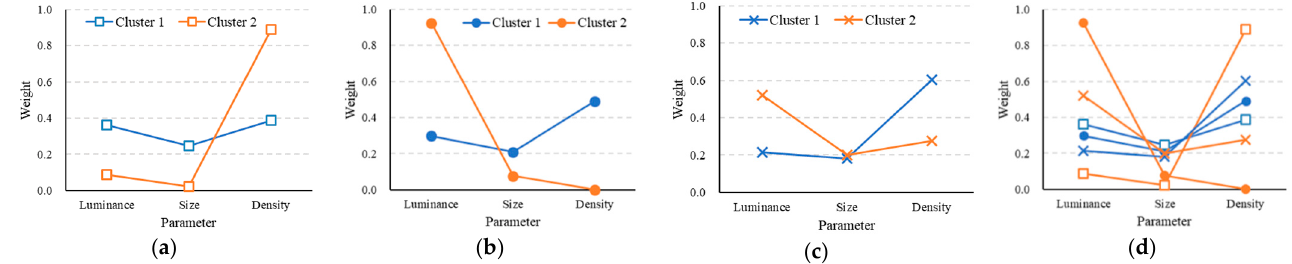
Figure 9. Weights in two clusters for each evaluation. ( a ) Faithfulness; ( b ) Preference; ( c ) Depth feeling; ( d ) Total compar- ison.